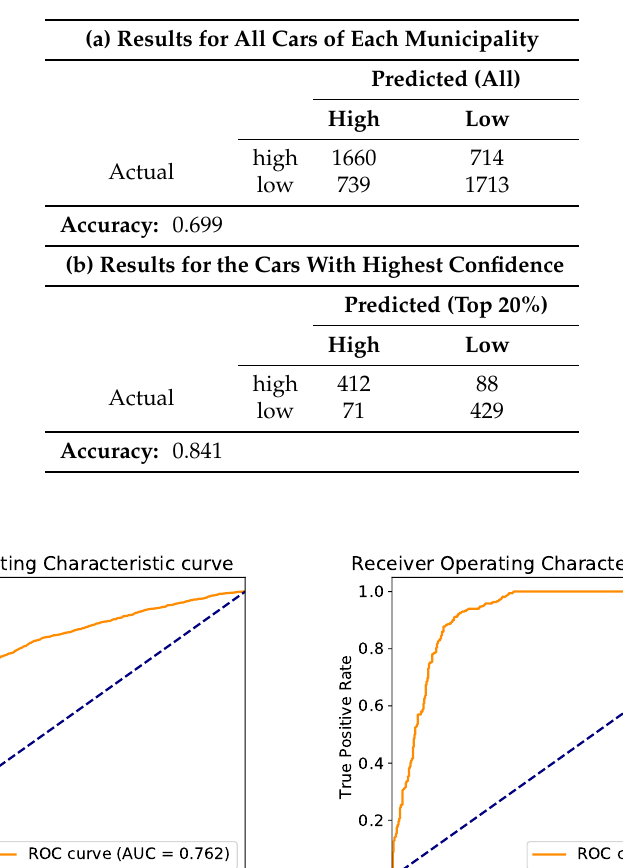
Table 1. Confusion matrices of the car classification models.